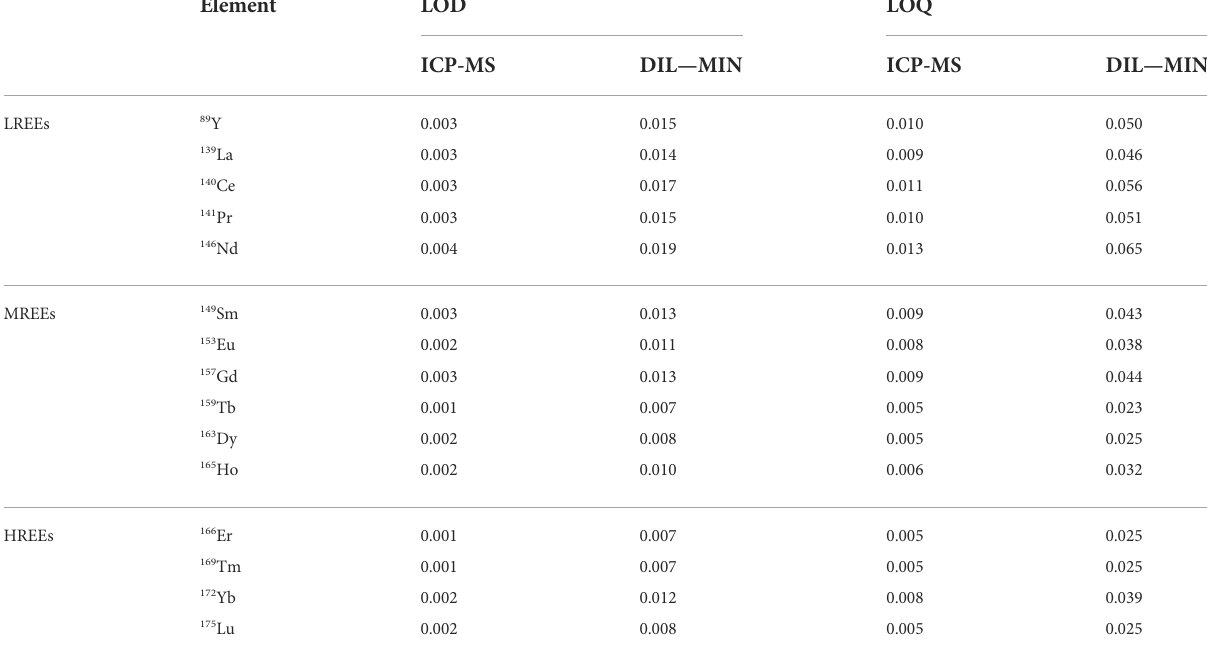
TABLE 3 Limits of detection (LODs) and limits of quanti fi cations (LOQs) evaluated for the instrument (ICP-MS) and for the preparation methods (dilution, DIL; digestion, MIN). All values are expressed in µg/L.